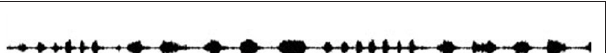
FIGURE 1 | A mammal acoustic signal.